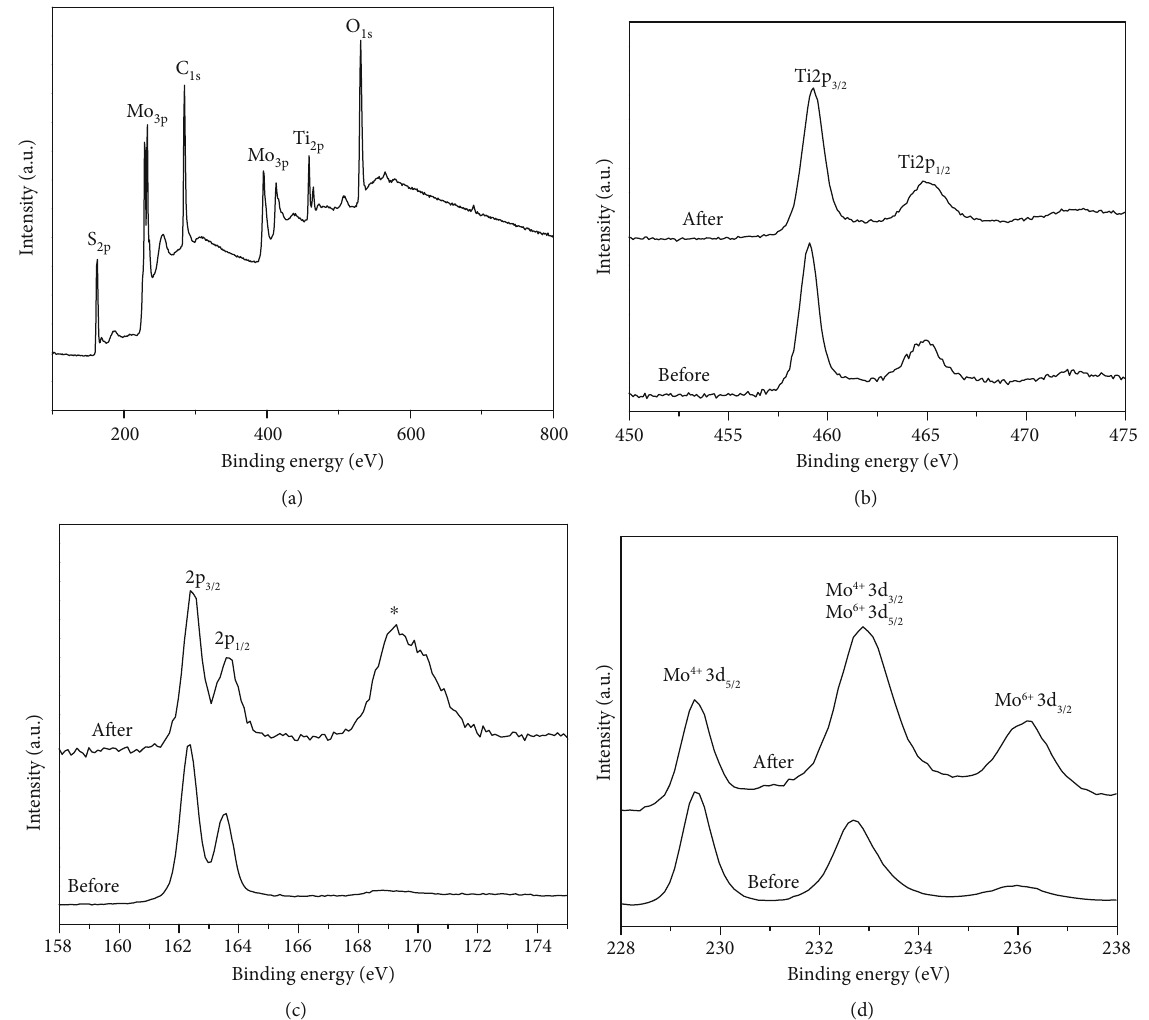
Figure 7: XPS spectra of TMTF sample (a) general survey, (b) high resolution of Ti 2p, (c) high resolution of S 2p, and (d) high resolution Mo 3d. The label before and after means before and after photocatalytic